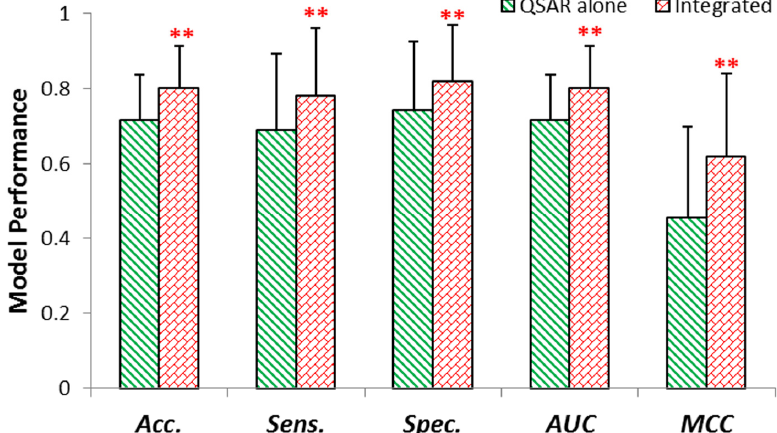
Figure 2. The performance of models using internal validation. QSAR alone model and Integrated model were evaluated by averaged Acc., Sens., Spec., AUC, MCC. ** p < 0.01 (compared to QSAR alone